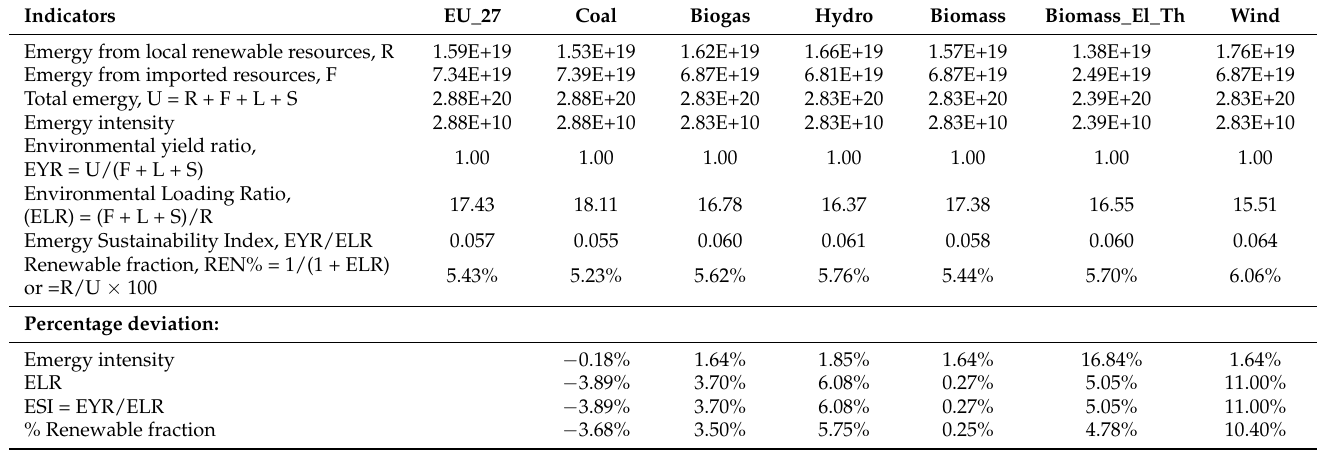
Table A3. Comparative analytic values of emergy flows and emergy-based indicators for the PHA production process using alternate energy